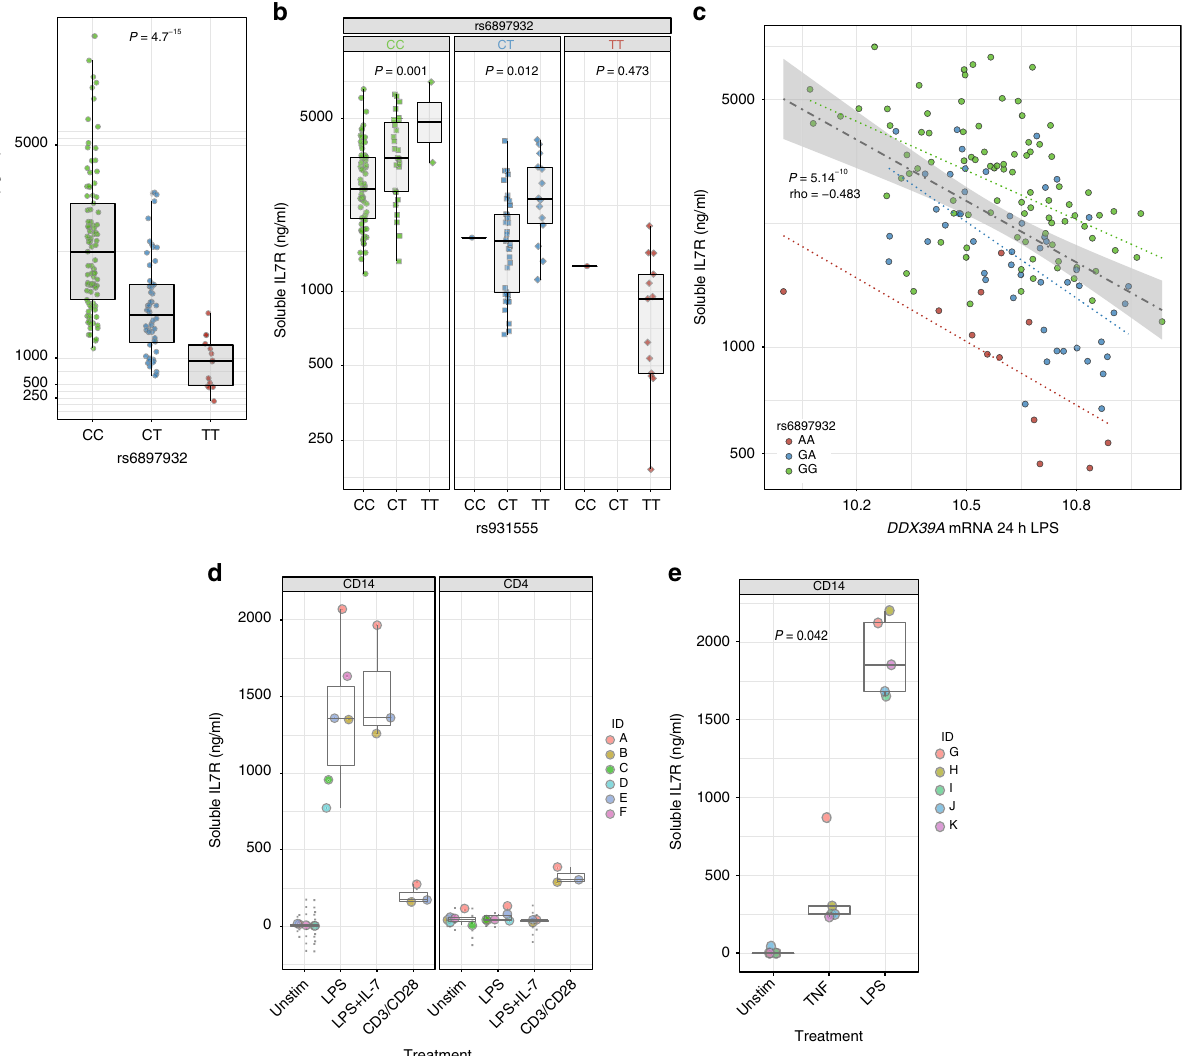
Fig. 3 Monocyte-derived soluble IL7R is regulated by rs6897932 carriage and DDX39A expression. a ELISA of sIL7R performed on supernatants of monocytes treated with LPS for 24 h. Samples were randomly chosen from original eQTL dataset and genotypes revealed post-hoc – a signi fi cant association was observed at rs6897932 ( n = 161, ANOVA for linear model). b ELISA data from a showing additional effect of rs931555 genotype on sIL7R (linear model). c Correlation analysis performed between 15421 microarray probes and soluble IL7R ( y -axis) identi fi ed DDX39A expression ( x -axis) to be signi fi cantly anti-correlated with soluble IL7R levels, supporting evidence for its regulation of soluble IL7R. Trend lines indicate correlation by allele, with rho and P -value for all data ( n = 161, Spearman rank analysis). d ELISA of sIL7R from isolated primary CD14 + and CD4 + cells cultured for 24 h either alone or in the presence of LPS, LPS + IL-7 and CD3/CD28 activating beads. ( n = 6). e ELISA of sIL7R from isolated primary CD14 + cultured for 24 h either alone, in the presence of TNF or in the presence of LPS ( n = 5, ANOVA). Error bars show mean, IQR, min and max. Source data are provided as a Source Data fi